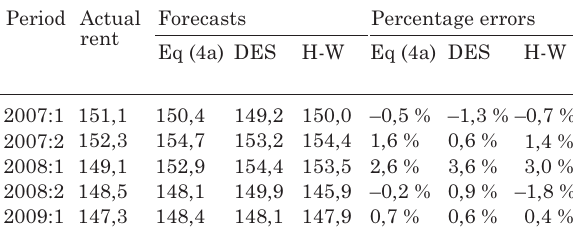
Table 3. Out of the sample forecasts for the model (4a) and two naïve methods, 2007:1–2009:1